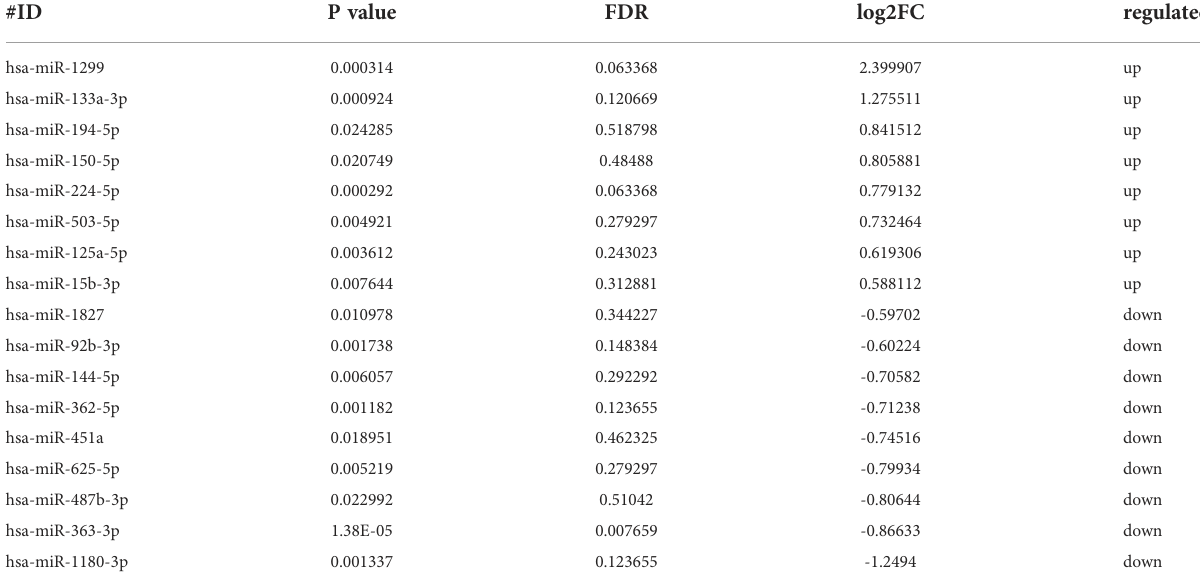
TABLE 2 Seventeen differential expression